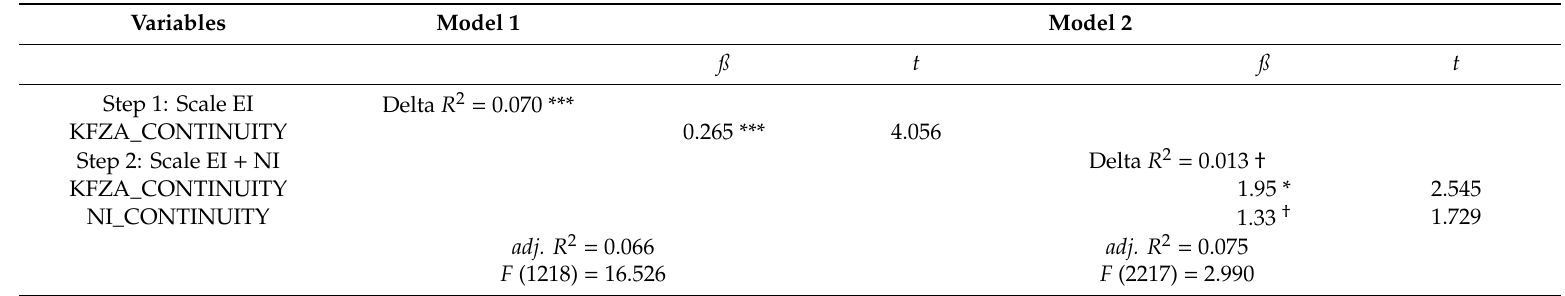
Table A8. Hierarchical regression analyses for the relation between well-being and scales from existing instruments (EI) and the new instrument (NI) assessing work continuity.